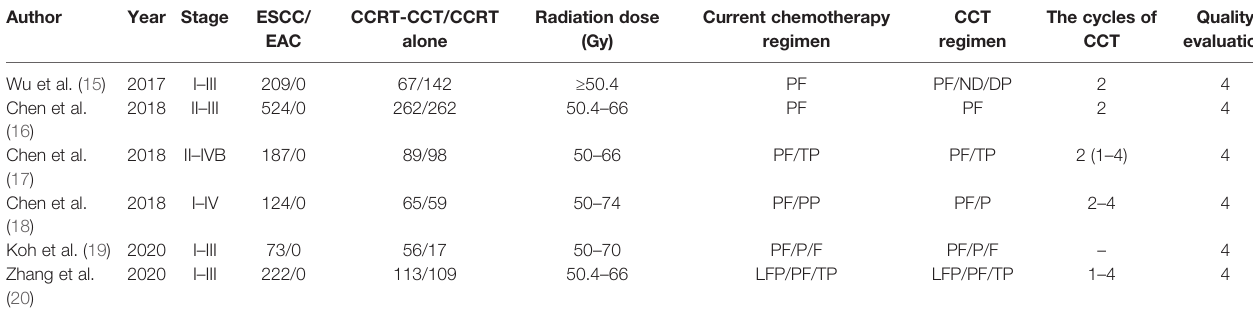
TABLE 2 | Basic characteristics of the included studies (CCRT-CCT vs . CCRT alone group).